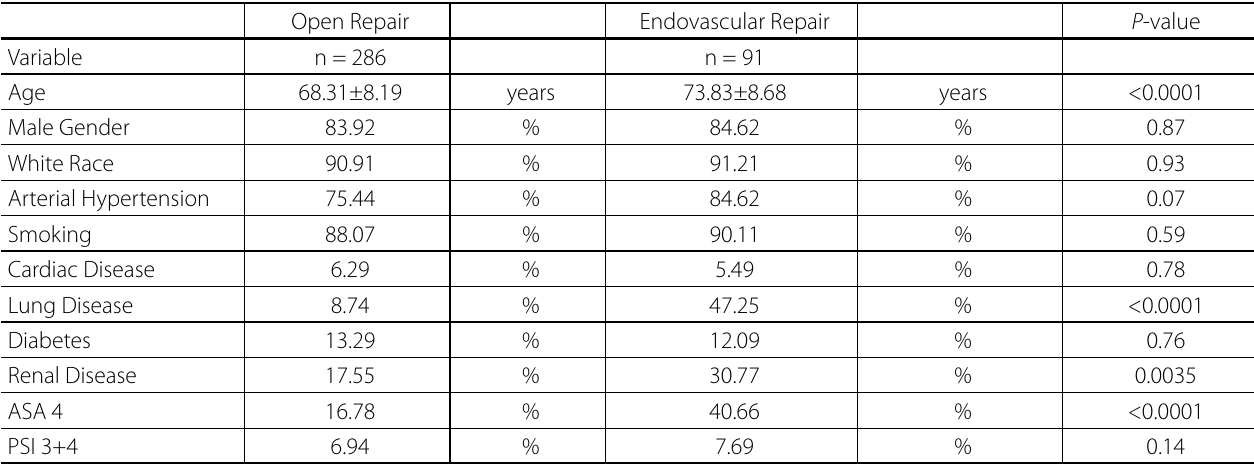
Table 1. Demographic data of the operated groups (2000-2013).